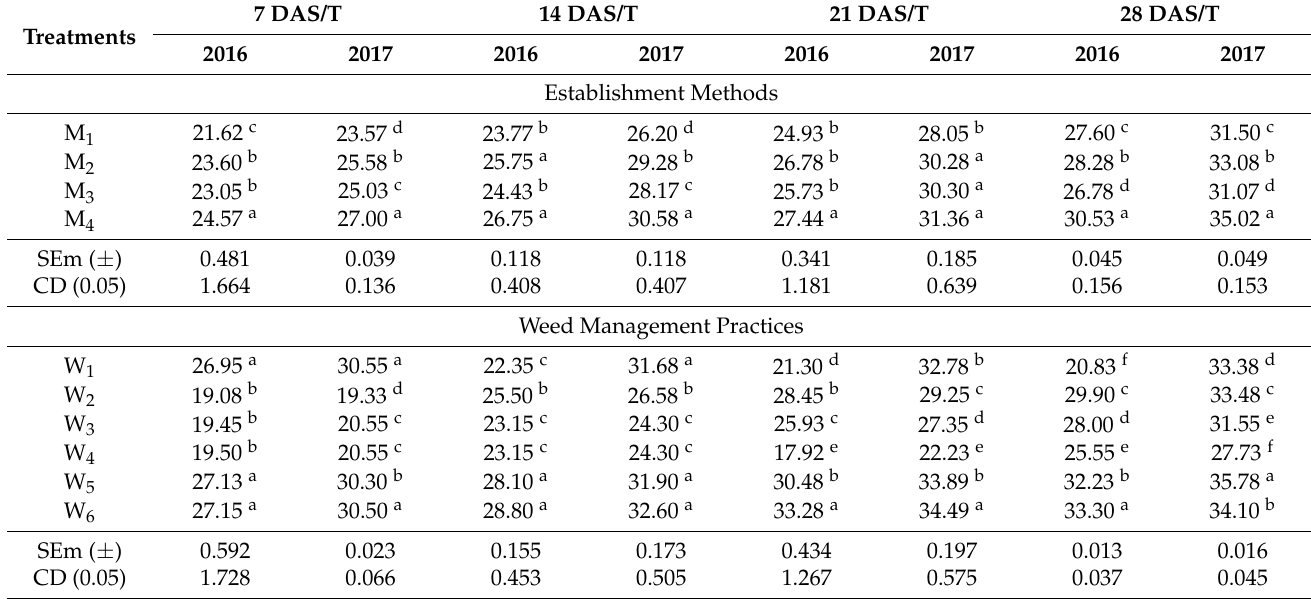
Table 8. Crop establishment methods and weed management practices influence the activity of the urease enzyme ( µ g NH3 released g − 1 soil h − 1 ) in rice